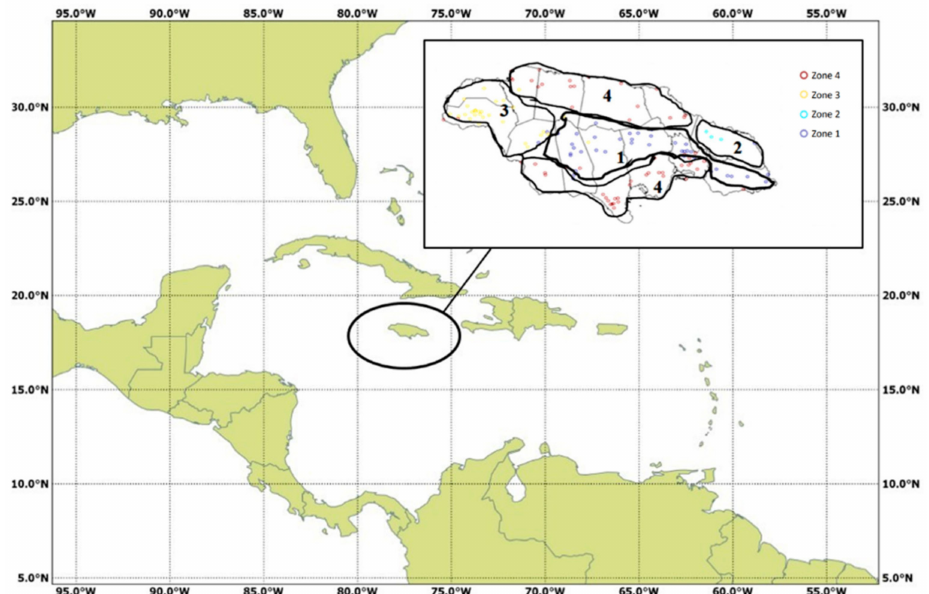
Figure 1. Map of the Caribbean. Inset diagram adapted from State of the Jamaican Climate 2015 showing a map of Jamaica with the approximate bounds for the four rainfall